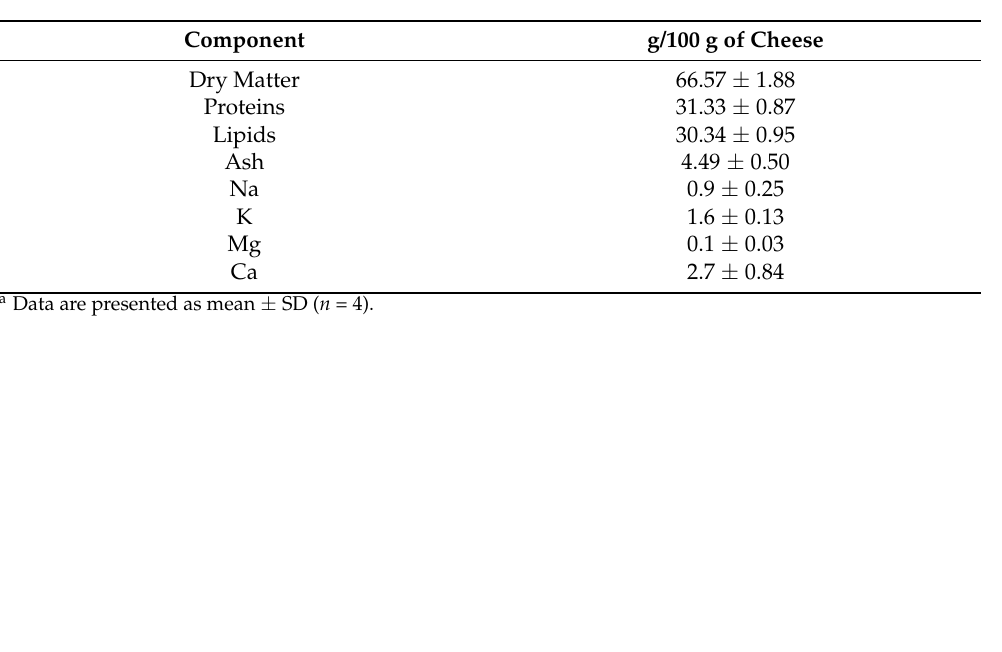
Table 1. Chemical composition and mineral elements (Mean ± SD) of Parmigiano Reggiano (PR) cheese a